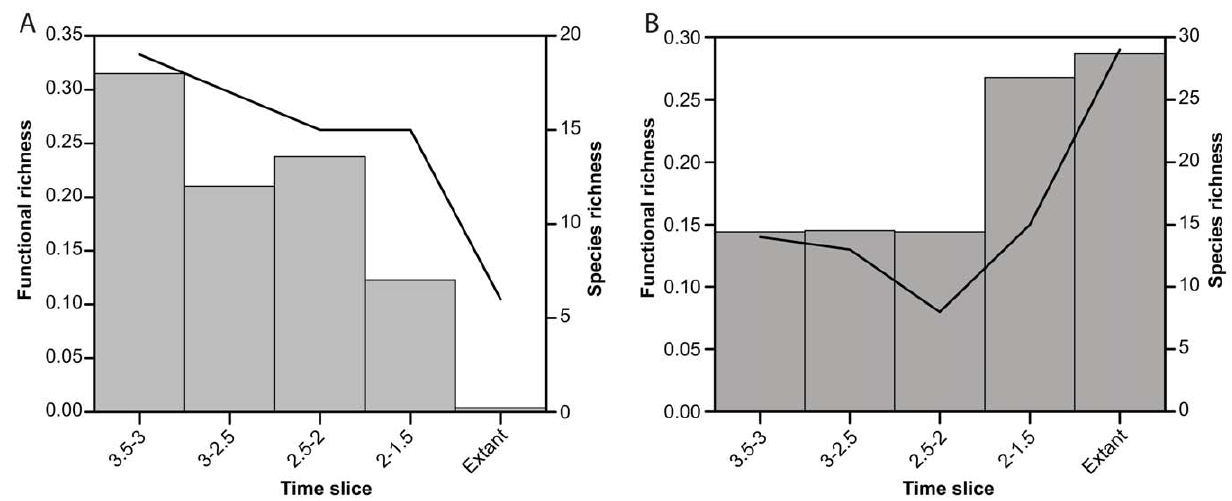
Figure 6. Functional richness and evenness through time. A. Diagram showing changes in functional richness (histogram; left Y scale) and species richness (line; right Y scale) in eastern African large carnivorans through time. B. Same as A, but for small carnivorans. The great difference between A and B is particularly important, see text.